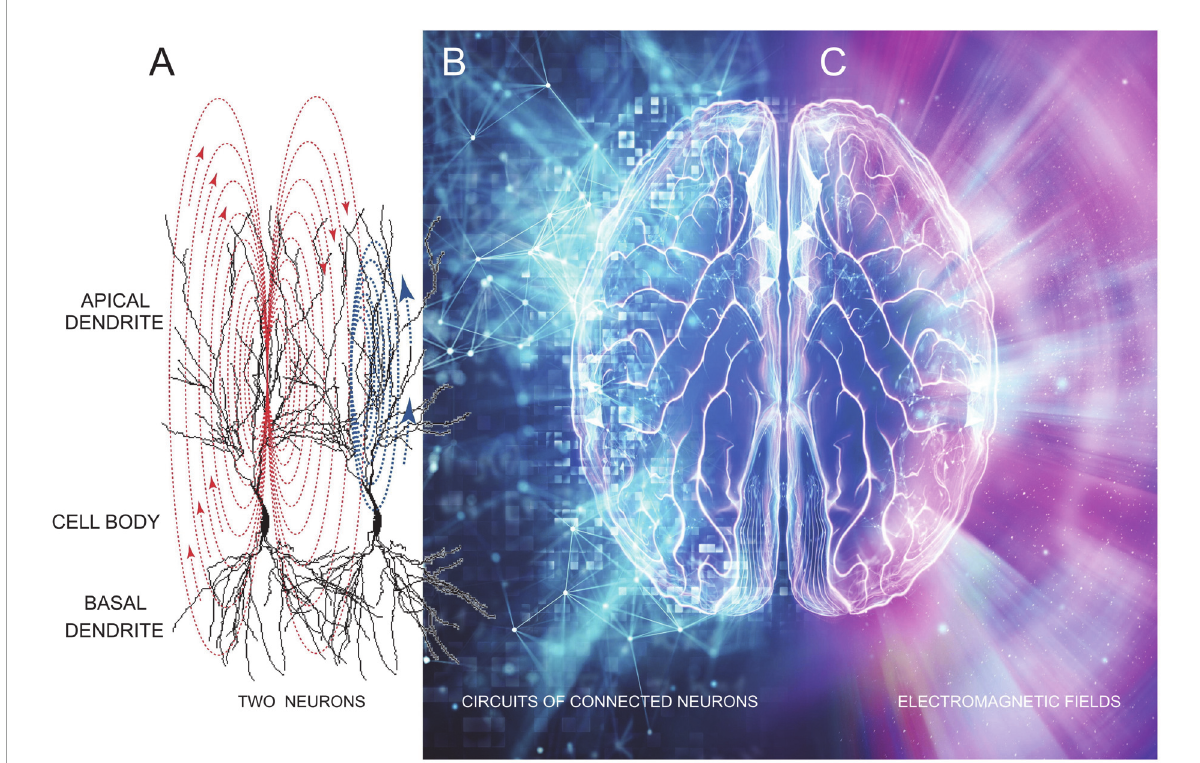
FIGURE1 A stylistic representation showing how brain neural circuitry (A,B) underlies the generation of EMFs (C) that unifies brain electrical activity into a conscious whole–that is our mind. Image was modified from